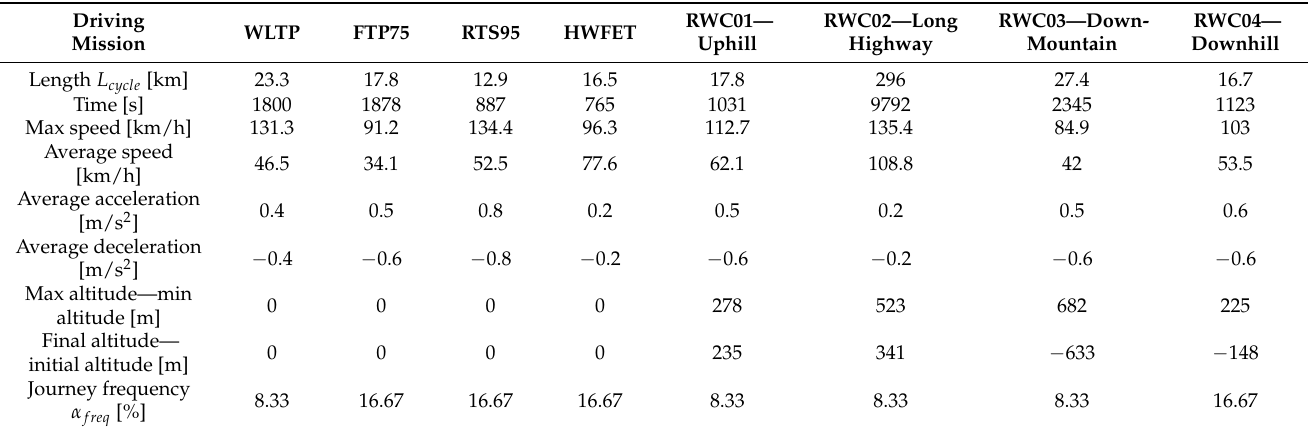
Table 5. Statistics for retained driving